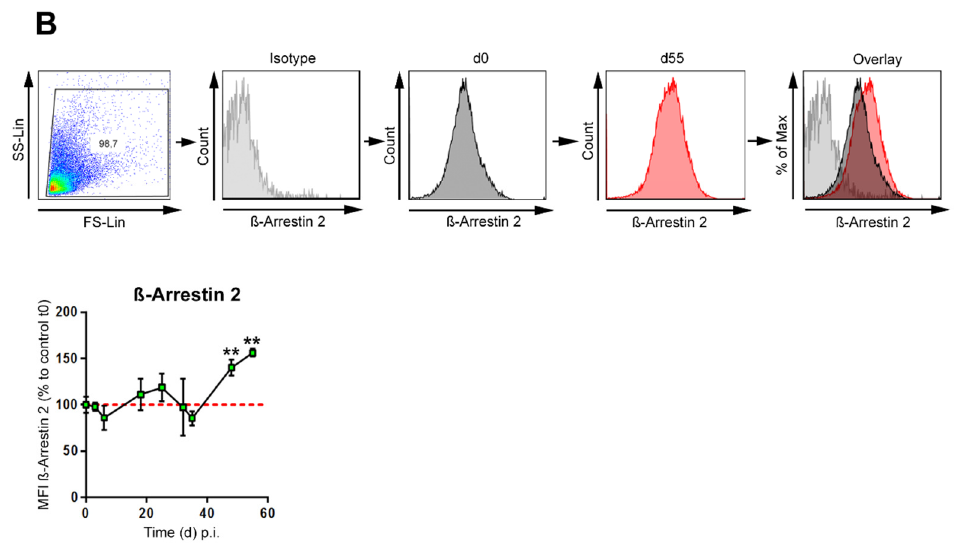
Figure 2. GRK-2 is downregulated during CIA, whereas β -Arrestin 2 is upregulated during es- tablished CIA in B cells. ( A , B ) Splenic B cells were isolated from immunized DBA/1J mice at the indicated days post immunization (p.i.). The mean fluorescence intensity (MFI) of GRK2 ( A ) and β -Arrestin 2 ( B ) was analyzed in B cells by flow cytometry ( n = 3–6). The results are shown in comparison to the mean value of d0 values from non-immunized mice (red reference line). The gating strategy is shown ( A , B ). Statistical significance was determined by ordinary one-way analysis of variance (ANOVA) followed by Bonferroni post-hoc test ( A ) or Student t -test ( B ). Images are shown ± SEM. Mean: GRK-2: d0: 28.4 ± 22.2; d3: 4.08 ± 0.7; d6: 1.58 ± 0.61; d18: 8.76 ±